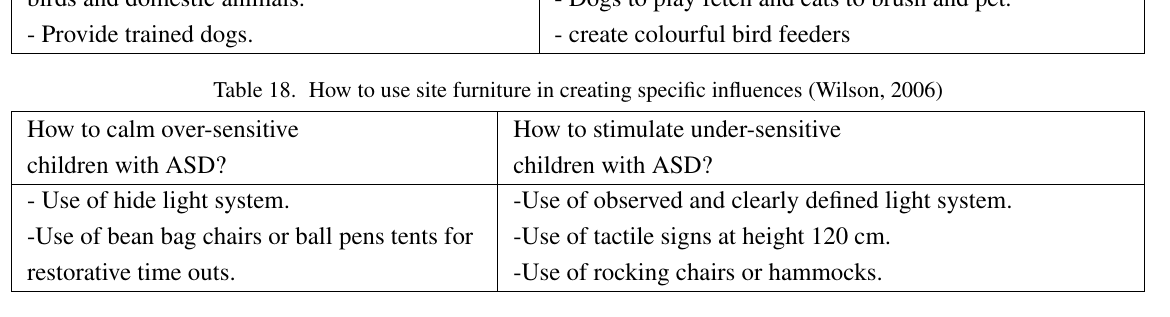
Table 19. How to use site furniture in creating specific influences (Wilson,